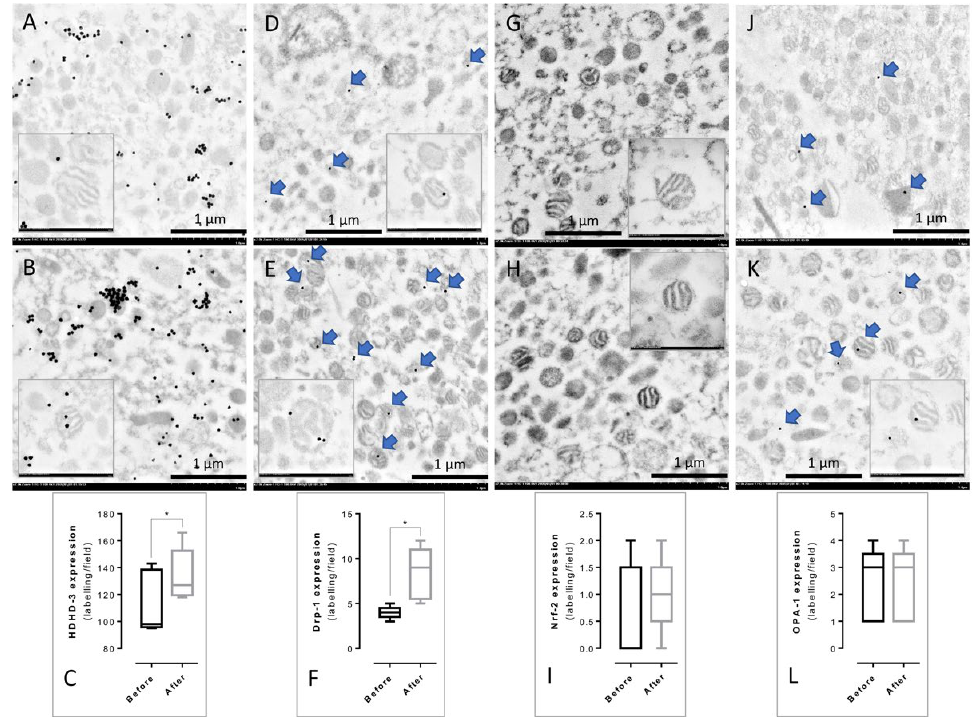
Figure 4. Immunogold labeling of the PBMCs’ mitochondria from the before and after treatment groups. Before treatment ( A , D , G , J ) and after treatment ( B , E , H , K ) with gold labeling (arrow) were revealed. The presence of mitochondrial function markers was represented in HDHD-3 ( A – C ), Drp-1 ( D – F ), Nrf-2 ( G – I ), and OPA-1 ( J – L ). All data in the bar graph are presented as the mean ± SD, * p < 0.05.